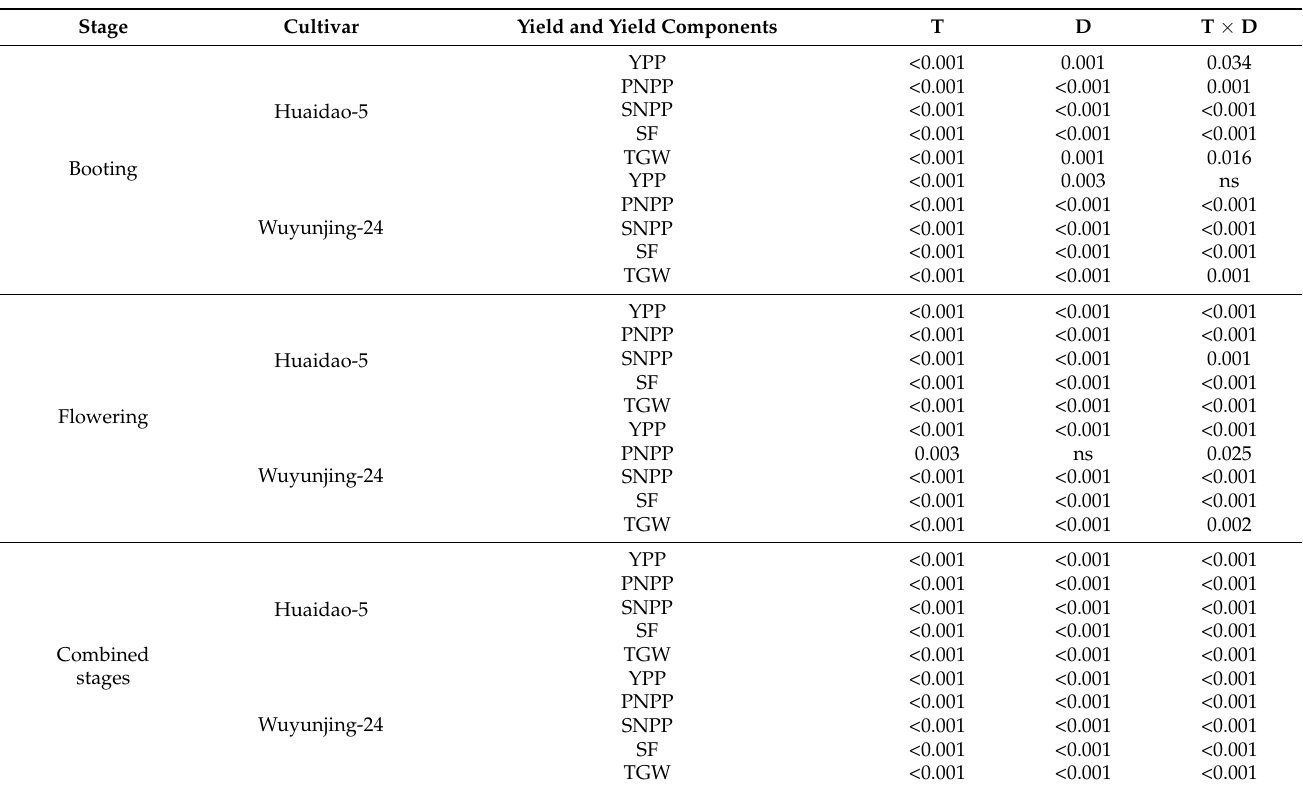
Table 2. Significance of main effects of high-temperature level (T) and duration (D), as well as their interaction (T × D) for grain yield and yield components (including original and regenerated tillers) of two rice cultivars at booting (BT), flowering (FL), and combined (BT + FL) stages during the 2016–2017 growing